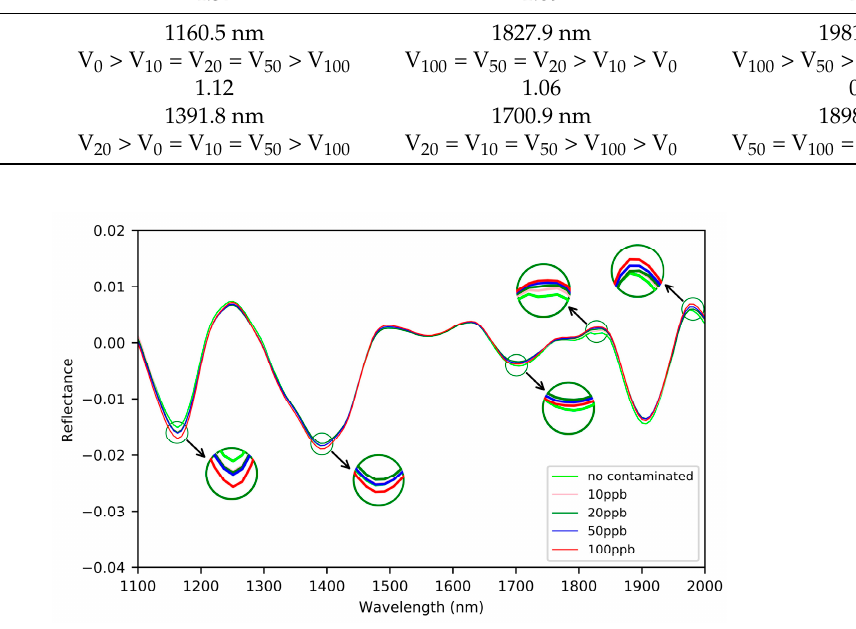
Figure 6. Five key wavelengths selected according to spectral feature.